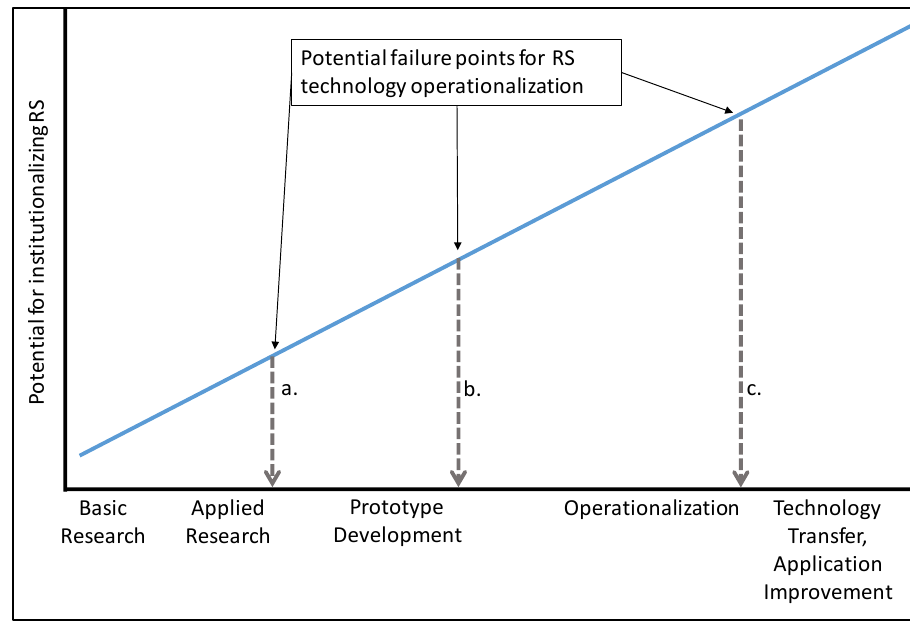
Figure 4. Conceptual graphic depicting the steps in a process in which the use of a new technology becomes institutionalized in Forest Inventory and Analysis (FIA). There are several points at which adoption of the technology might fail, including after applied research has been attempted ( a ), after prototype development ( b ), or after operationalization ( c ).